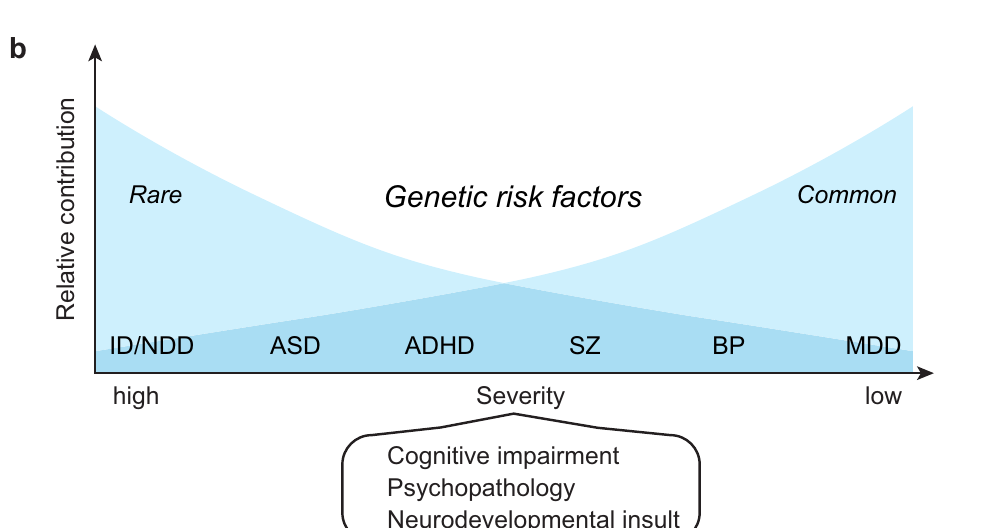
temperature and following a fi nal PBS wash, mounted using Dako Fluorescence Mounting Medium (Agilent) and glass coverslips. Imaging was with either the LSM710 confocal microscope (Zeiss) using Zen 2012 SP2 (black) v11.02.190 (Zeiss), LAS X for DMI6000B inverted microscope (Leica) or Cellinsight Cx7 High-Content Screening Platform (Thermo Fisher Scienti fi c) with HCS Studio Cell Analysis soft- ware v6.6.0 (Thermo Fisher Scienti fi c) used for quanti fi cation. Western blotting . Total protein was extracted from dissociated cultured cells by incubating in 1x RIPA buffer (New England Biolabs) with added MS-SAFE Protease and Phosphatase Inhibitor (Sigma) for 30 min on ice with regular vortexing, concentration was determined using a DC Protein Assay (BioRad) quanti fi ed with the CLARIOstar microplate reader (BMG Labtech). Proteins for western blotting were incubated with Bolt LDS sample buffer (Thermo Fisher Scienti fi c) and Bolt Sample Reducing Agent (Thermo Fisher Scienti fi c) for 10 min at 70 °C before loading into Bolt 4 – 12% Bis-Tris Plus gels (Thermo